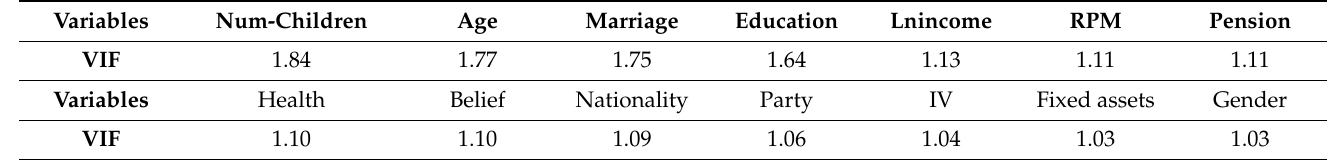
Table 2. The collinearity test results.